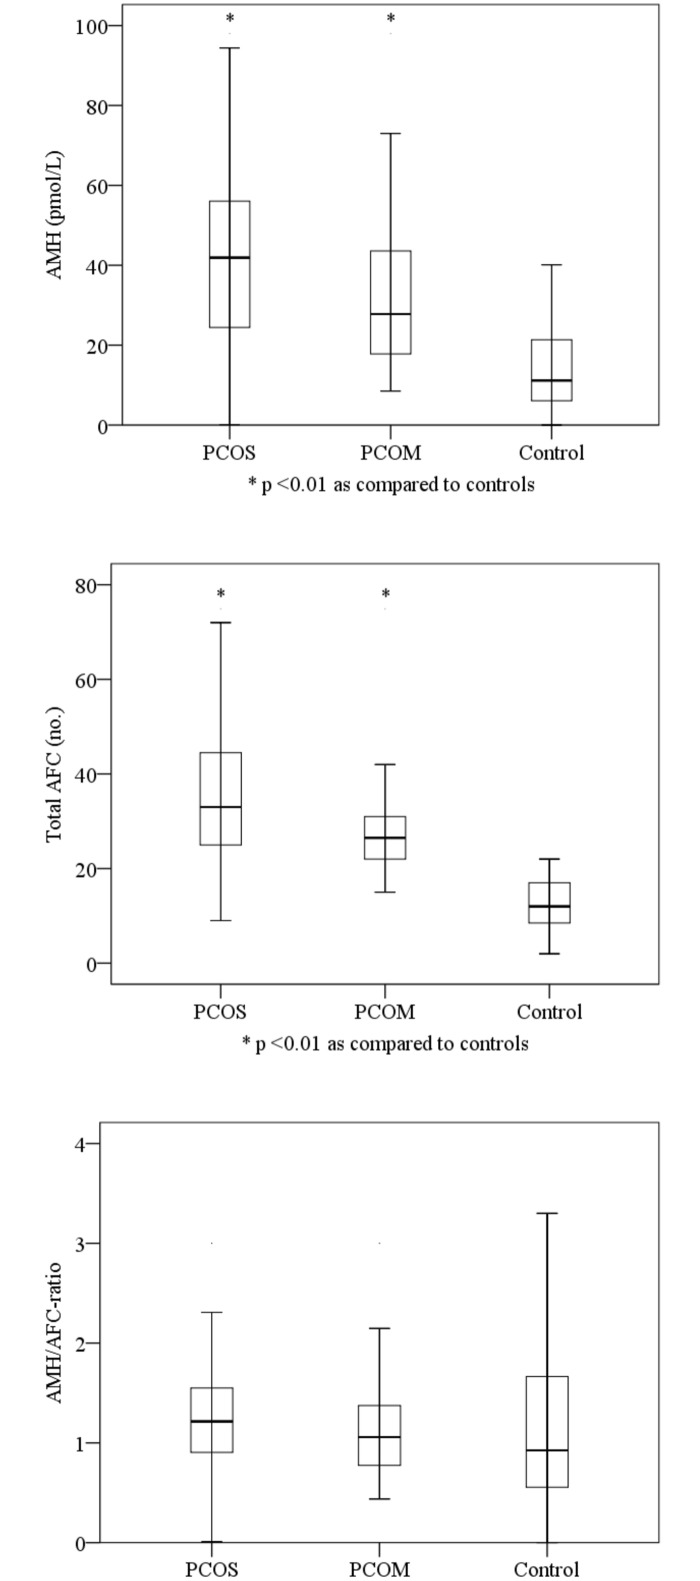
Boxplots of AMH, AFC and AMH/AFC-ratio in women with PCOS, PCOM and normal controls.